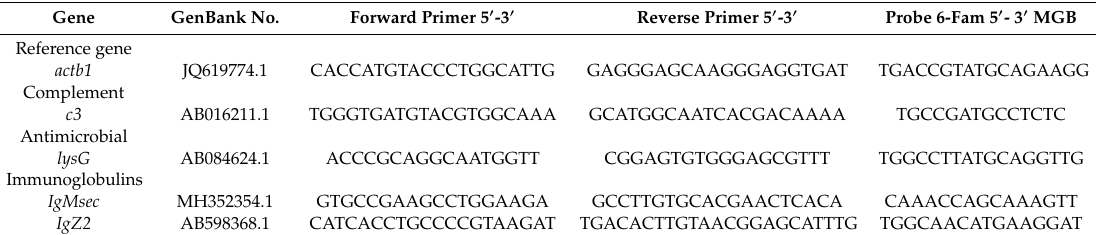
Table 2. Summary of the common carp Cyprinus carpio genes and nucleotide sequences of the primers and probes used for the Taqman qPCR assays: beta-actin ( actb1 ); complement c3-h1 ( c3 ); lysozyme g ( lysG ); immunoglobulin M heavy chain secretory protein ( IgMsec ); and immunoglobulin heavy chain Z2 ( IgZ2